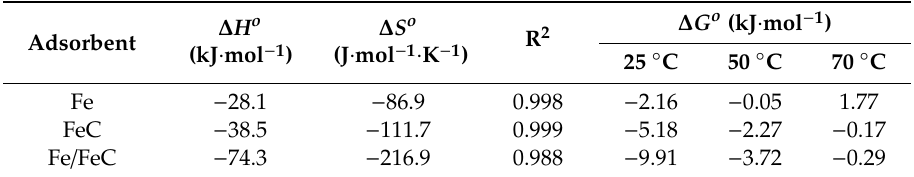
Figure 8. Vant’ Hoff plots for Acid Red 66 adsorption on ( a ) Fe, ( b ) FeC and ( c ) Fe / FeC. Figure 8. Vant’ Ho ff plots for Acid Red 66 adsorption on ( a ) Fe, ( b ) FeC and ( c ) Fe / FeC. Table 5. Thermodynamic parameters the adsorption the Acid Red 66 dye over the samples at distinct